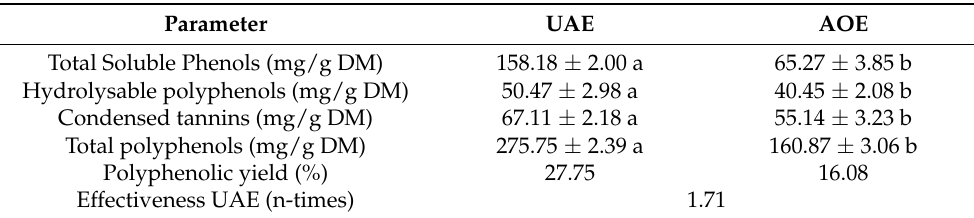
Table 4. Total soluble phenols, hydrolysable polyphenols, condensed tannins, and total polyphenols from Psidium cattleianum leaf extracts using the optimal conditions for ultrasound-assisted extraction and conventional aqueous–organic extraction, yield, and